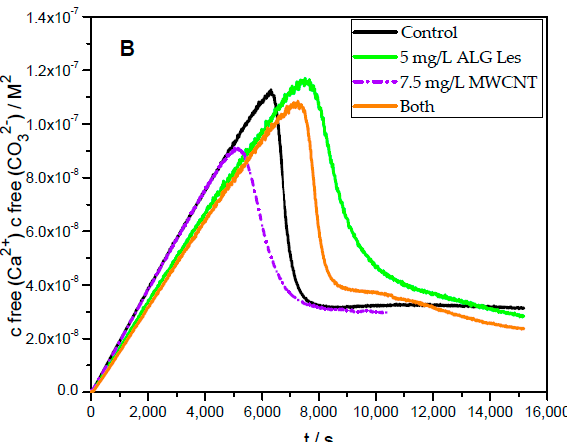
Figure 8. Time development of CaCO 3 solubility products using 5 mg/L ALG Les and MWCNT of 2.5 mg/L ( A ) and 7.5 mg/L ( B ) concentrations at pH 9.0: Blank (black line), 5 mg/L ALG Les (green line), 2.5 mg/L MWCNT (purple straight line) and 7.5 mg/L MWCNT (purple dash dot line), and both in mixture (orange line).